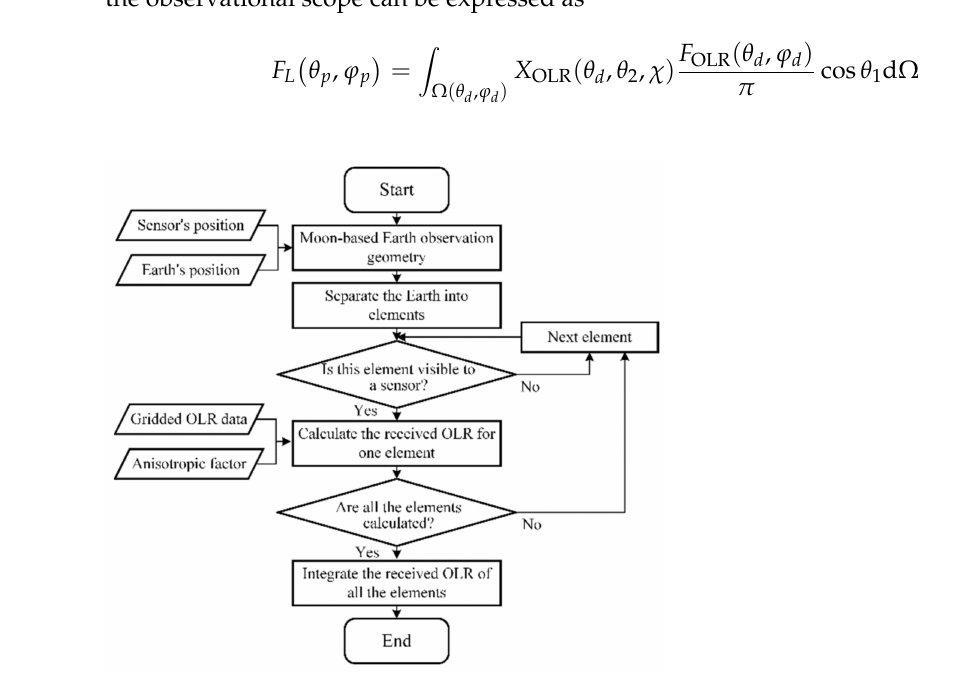
Figure 2. Diagram of the construction process of the theoretical